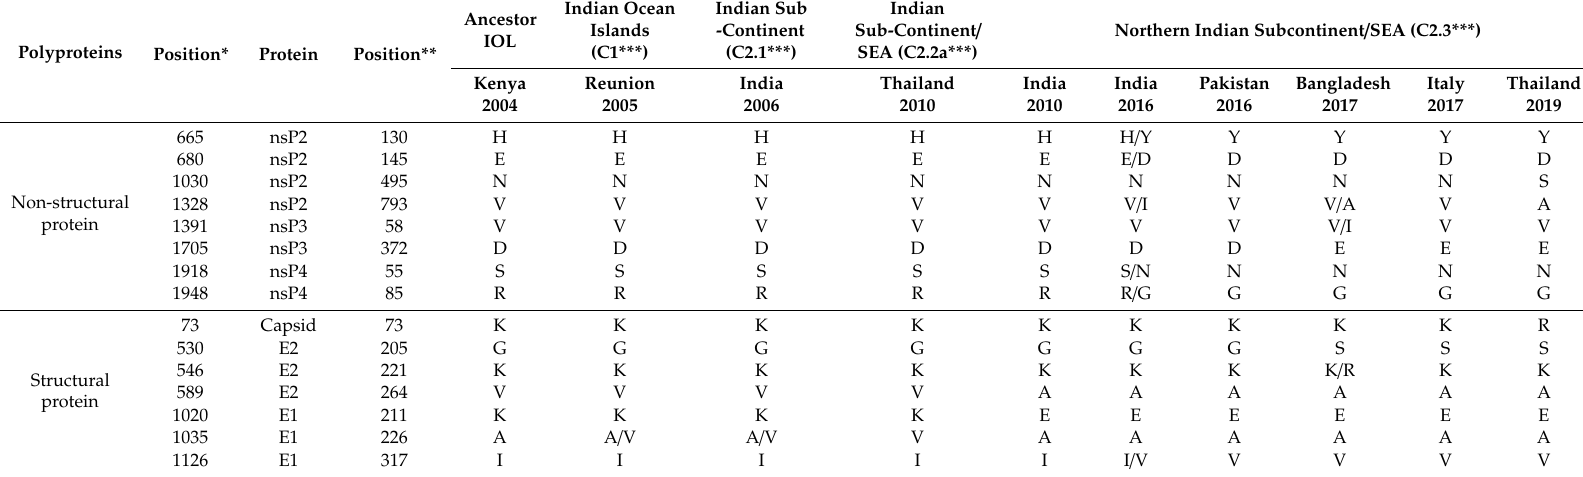
Table 3. Nonsynonymous amino acid substitutions in CHIKV ECSA-IOL sub-lineages among CHIKV outbreak strains compared to the ancestor IOL.